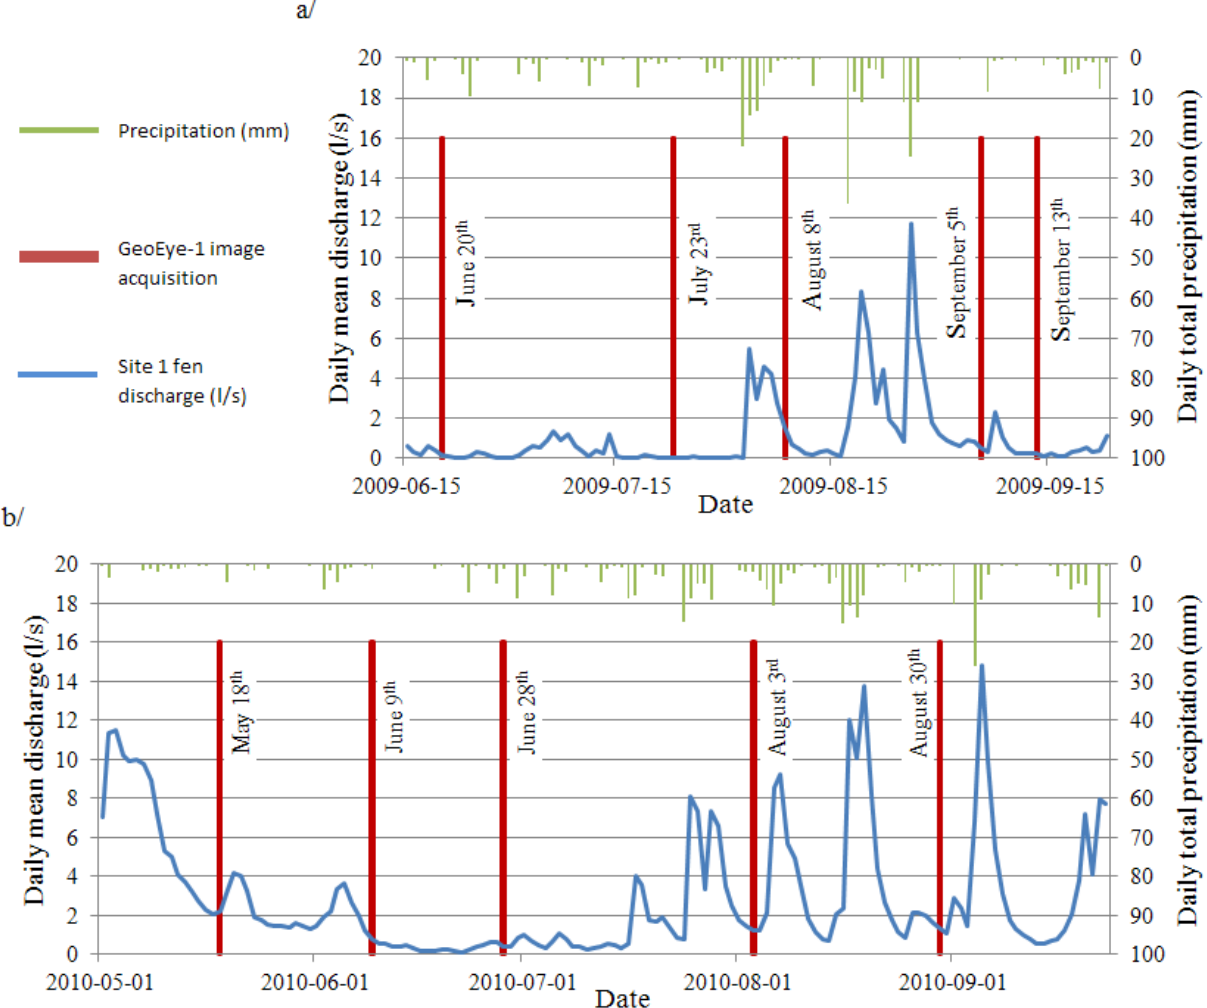
Figure 3. GeoEye-1 image acquisitions and hydrological conditions during: ( a ) spring and summer 2009; ( b ) spring and summer